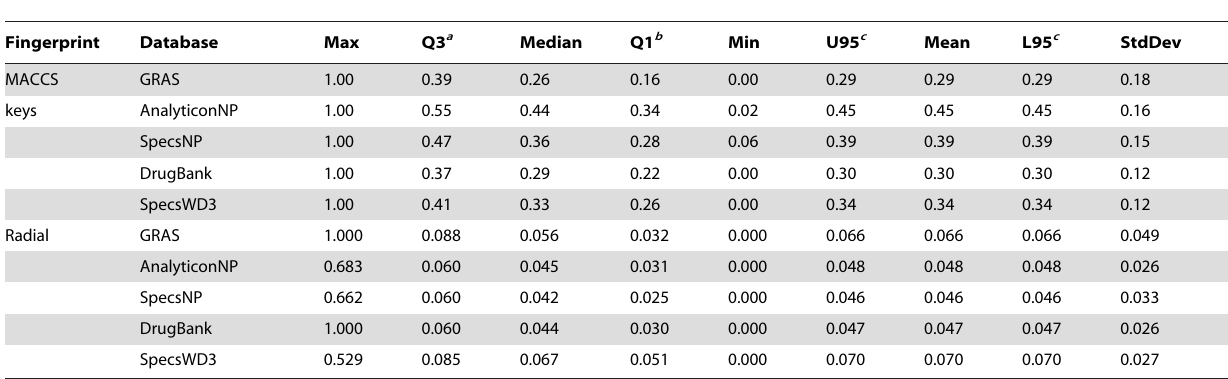
Table 2. Summary of the intra-library similarity computed with MACCS keys and radial